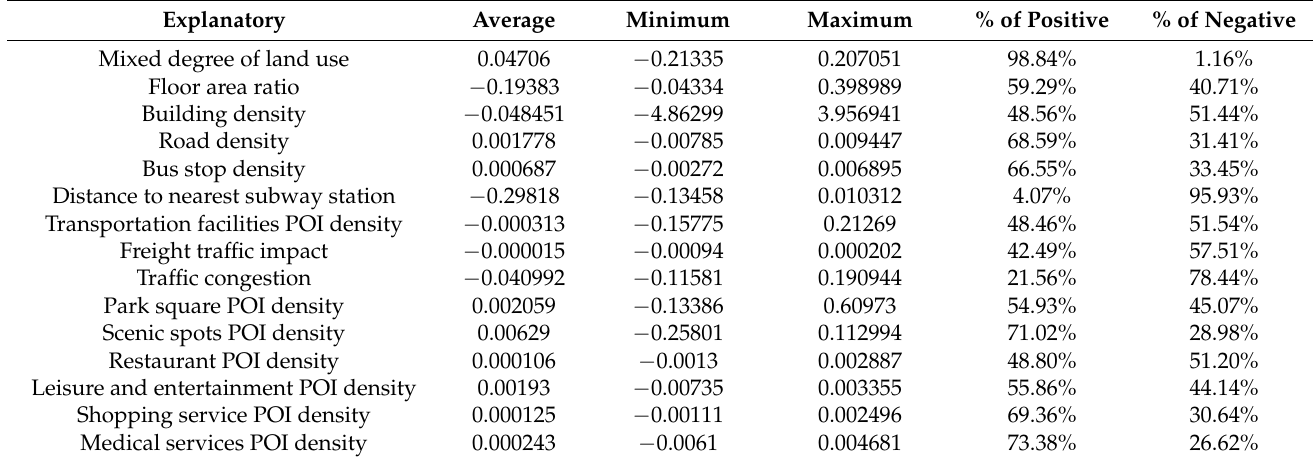
Table 9. Distribution of the regression coefficients of independent